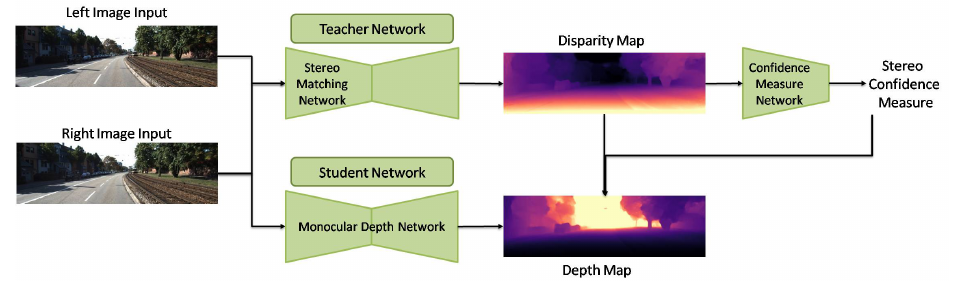
Figure 16. Developed network by Cho et al.